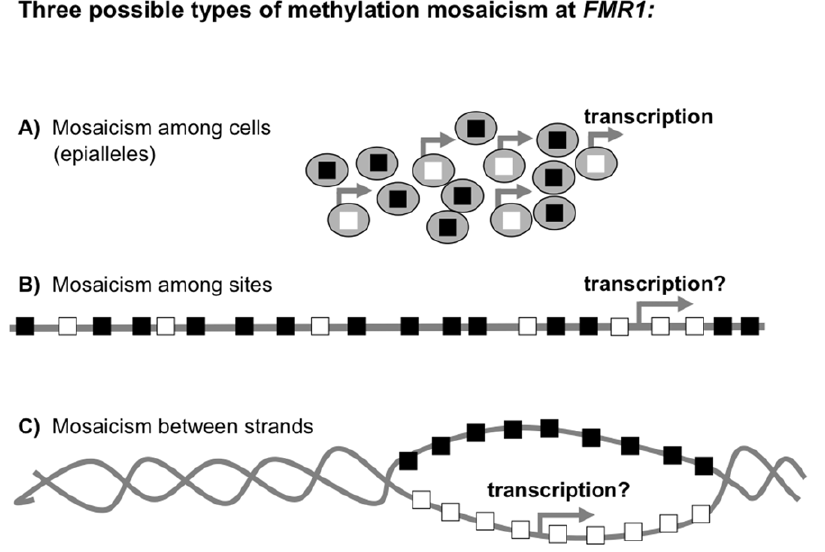
Figure 1. Three possible types of mosaicism for cytosine methylation at FMR1 . (A) Mosaicism among cells, with either unmethylated (open squares) or hypermethylated (filled squares) epialleles; (B) mosaicism among CpG sites; and (C) mosaicism between the two strands of an individual DNA molecule. For the latter two possibilities, each square represents a CpG on a single strand of DNA; filled boxes depict methylated CpGs and open boxes depict unmethylated CpGs. Arrows represent possible transcriptional activity under each methylation-mosaicism scenario.